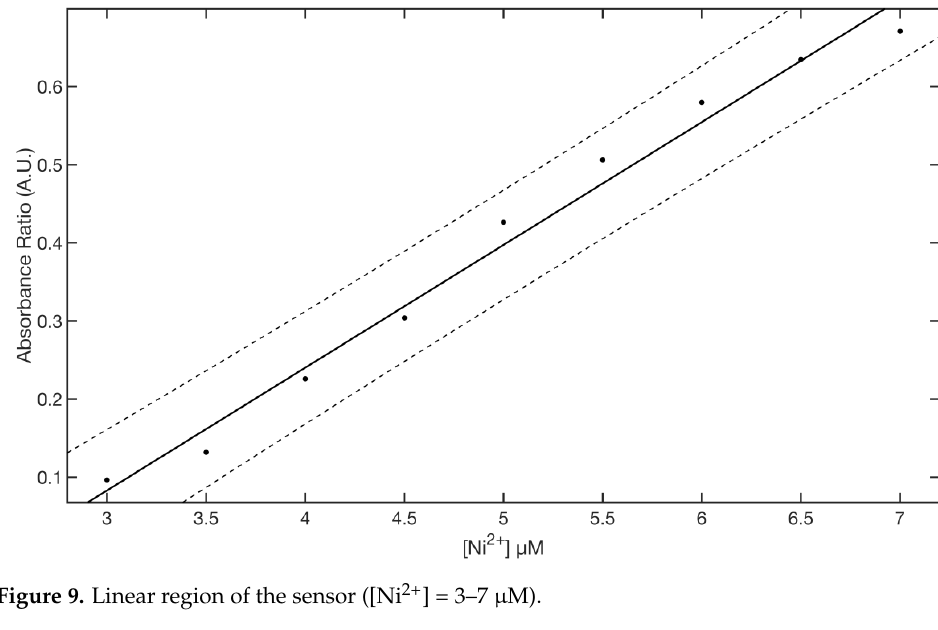
Figure 9. Linear region of the sensor ([Ni 2+ ] = 3–7 µM).